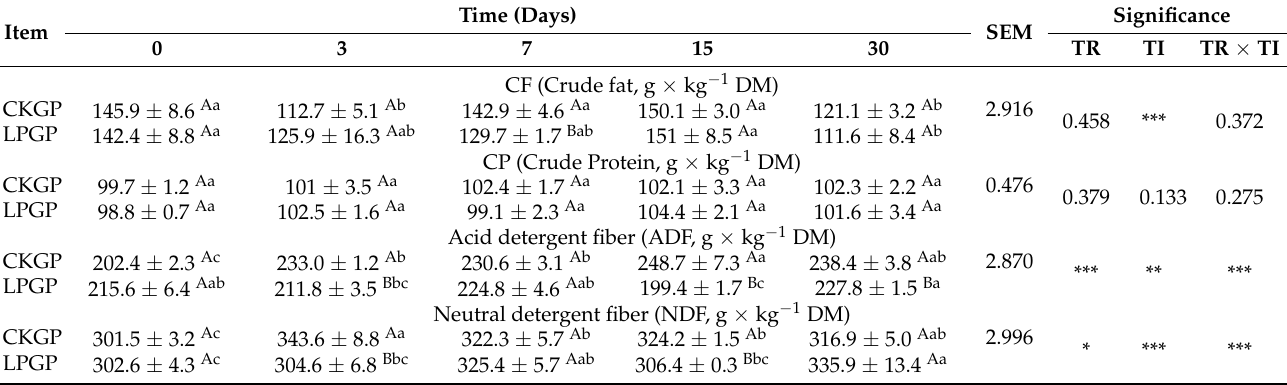
Table 3. Effects of inoculation and fermented time on nutrition composition of the